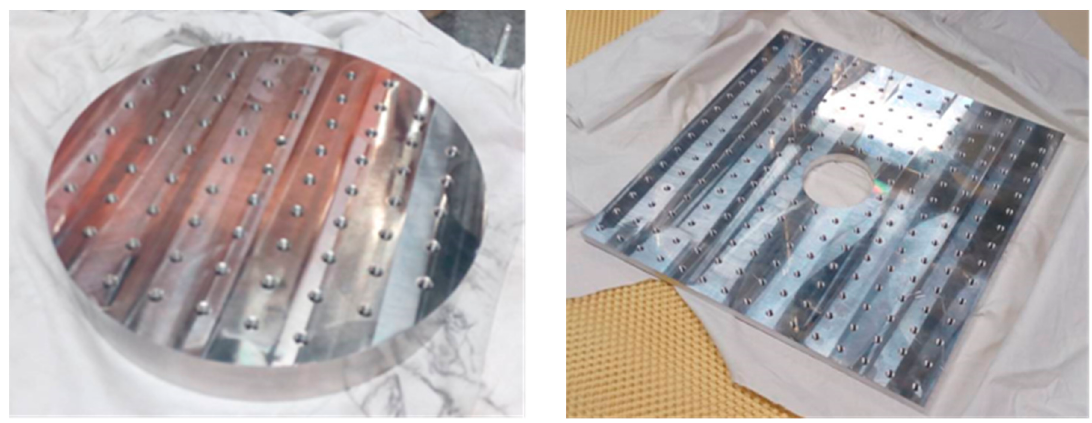
Figure 12. Bottom part of LN 2 vessel ( left ), and baseplate ( right ), after machining.